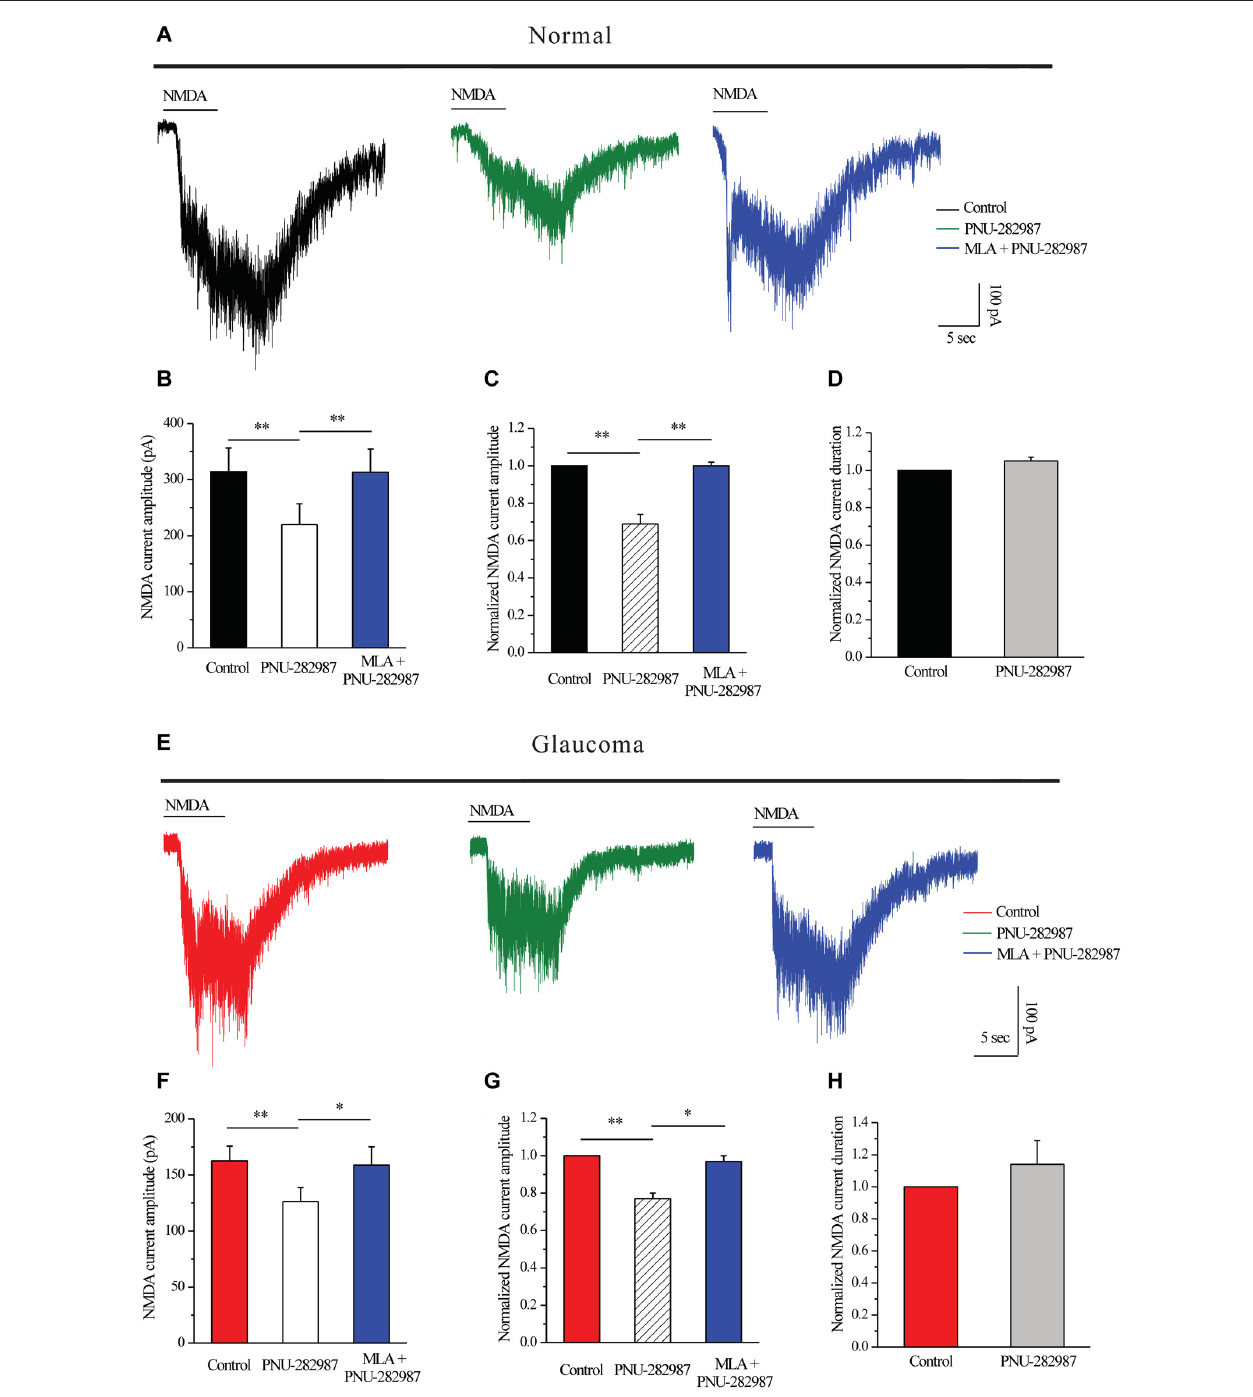
FIGURE 6 | PNU-282987 modulated NMDA-elicited whole-cell currents in RGCs of the rat retina slice. (A) In normal RGCs, representative NMDA-induced currents in control, in the presence of 10 µ M PNU-282987 and 100 nM MLA + 10 µ M PNU-282987. (B) Summarized data of NMDA current amplitude from five normal RGCs. (C) Normalized NMDA current amplitude from five normal RGCs. (D) Normalized NMDA current duration from five normal RGCs. (E) In glaucomatous RGCs, representative NMDA-induced currents in control, in the presence of 10 µ M PNU-282987 and during 100 nM MLA + 10 µ M PNU-282987 application. (F) Statistical analysis of NMDA current amplitude from four glaucomatous RGCs. (G) Normalized NMDA current amplitude from four glaucomatous RGCs. (H) Normalized NMDA current duration from four glaucomatous RGCs. Vertical calibration bar, 100 pA; horizontal calibration bar, 5 s. ∗ p < 0.05, ∗∗ p < 0.01 (one-way analysis of variance). The results are expressed as the mean ± standard